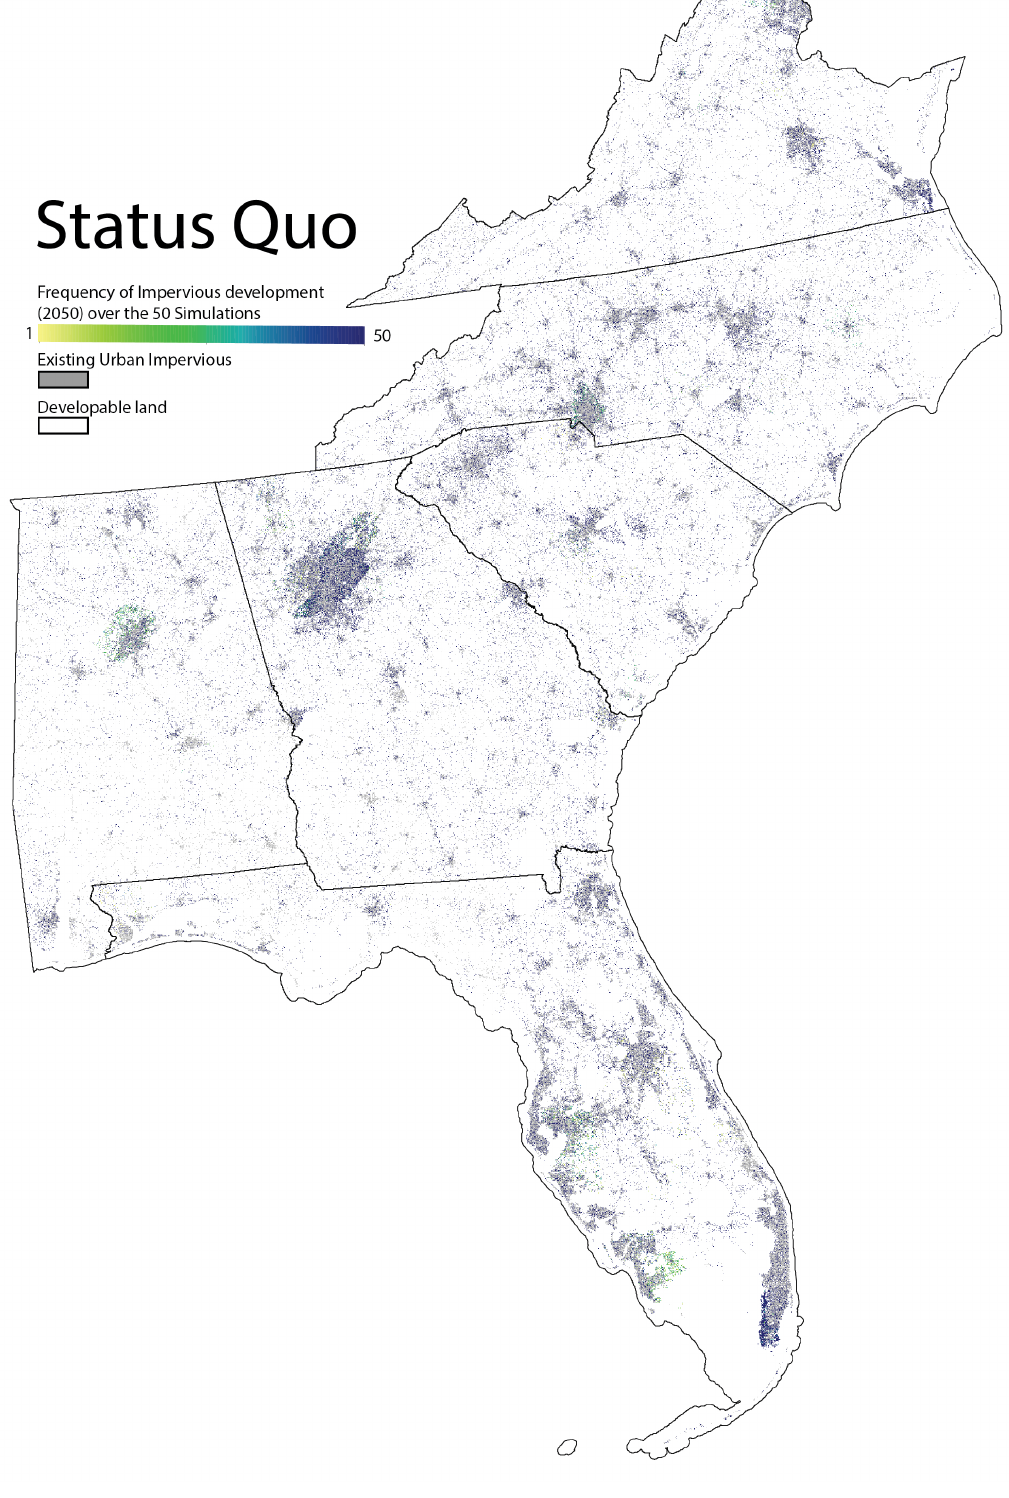
Figure A1. High resolution (30 m) development frequency map of an urban status quo development